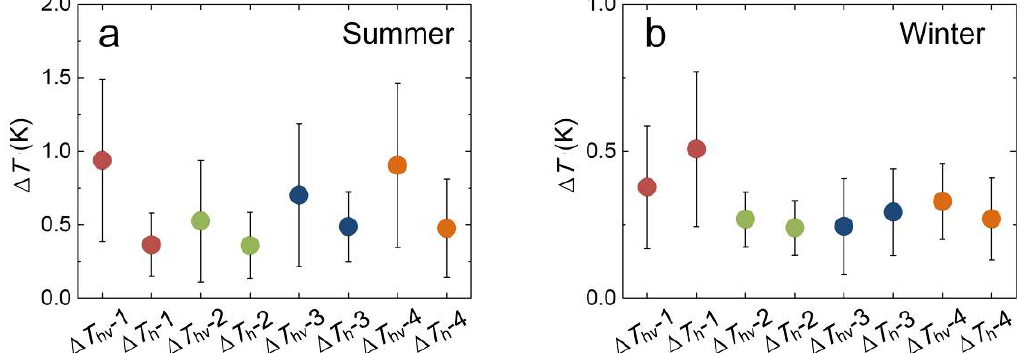
Fig.6 Comparison of T h based on kernel model and T c . The Y-axis is the mean absolute difference | ∆ T | between hemisphere integral temperature and Tc, the circle represents the mean of | ∆ T | and the bound of 0.5 times standard deviation. The ∆ T h is absolute difference | ∆ T | calculated from T h (calculated by the original T ( θ , φ )) and T c , The ∆ T hv is absolute difference | ∆ T | calculated from T hv (calculated by T' ( θ , φ ) simulated by Vinnikov model) and T c , the latter 1, 2, 3 and 4 represent 4 classes of TUS, respectively. and then decreases to 0.44 K. In other words,